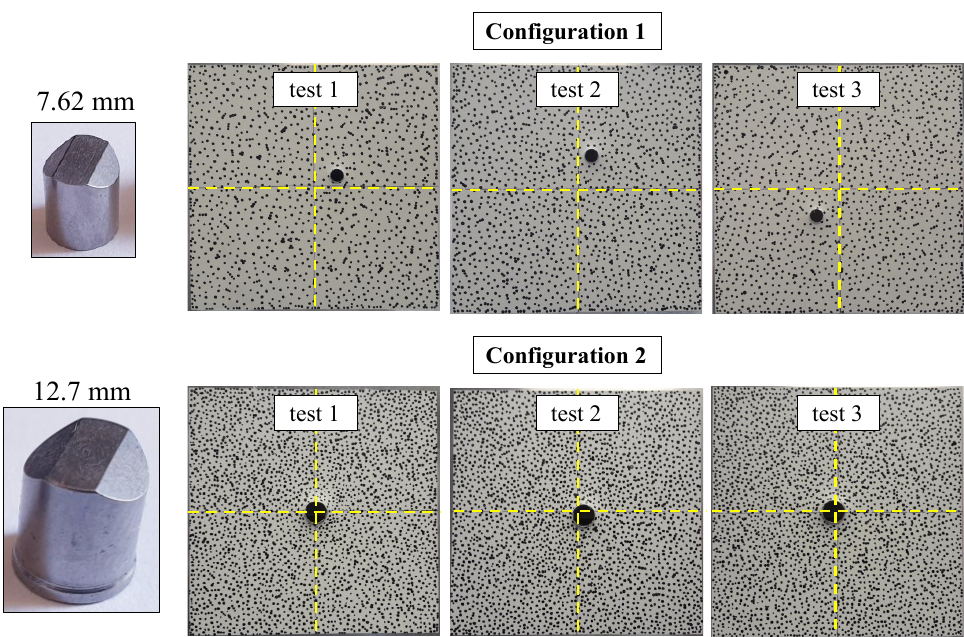
Figure 4. Plane view of aluminum plate specimens (configurations 1 and 2) after full FSP perforation.